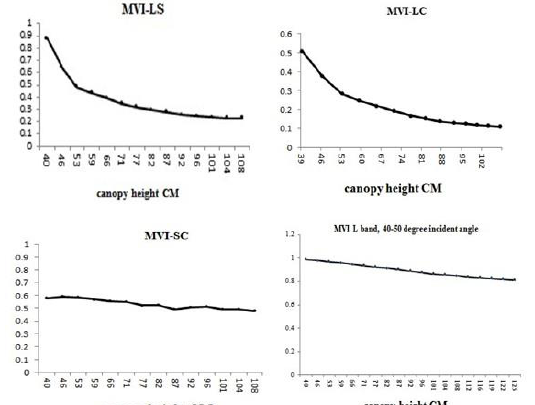
Figure 4, MVI in different frequencies (MVI_LS, MVI_LC, MVI_SC and MVI_CX), and also in 40, 50 angles of L band